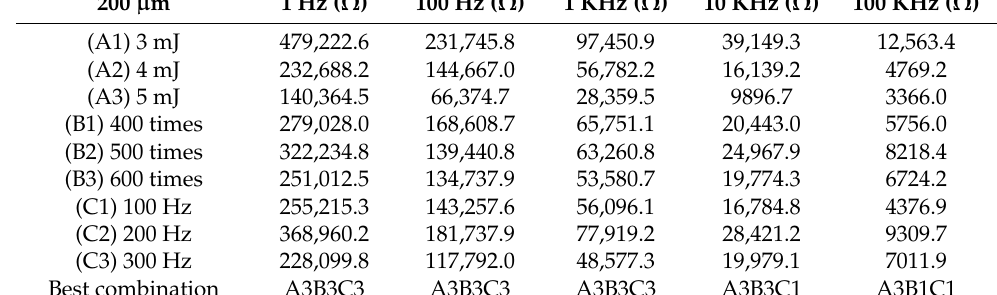
Table 8. Total average data for the corresponding frequency.